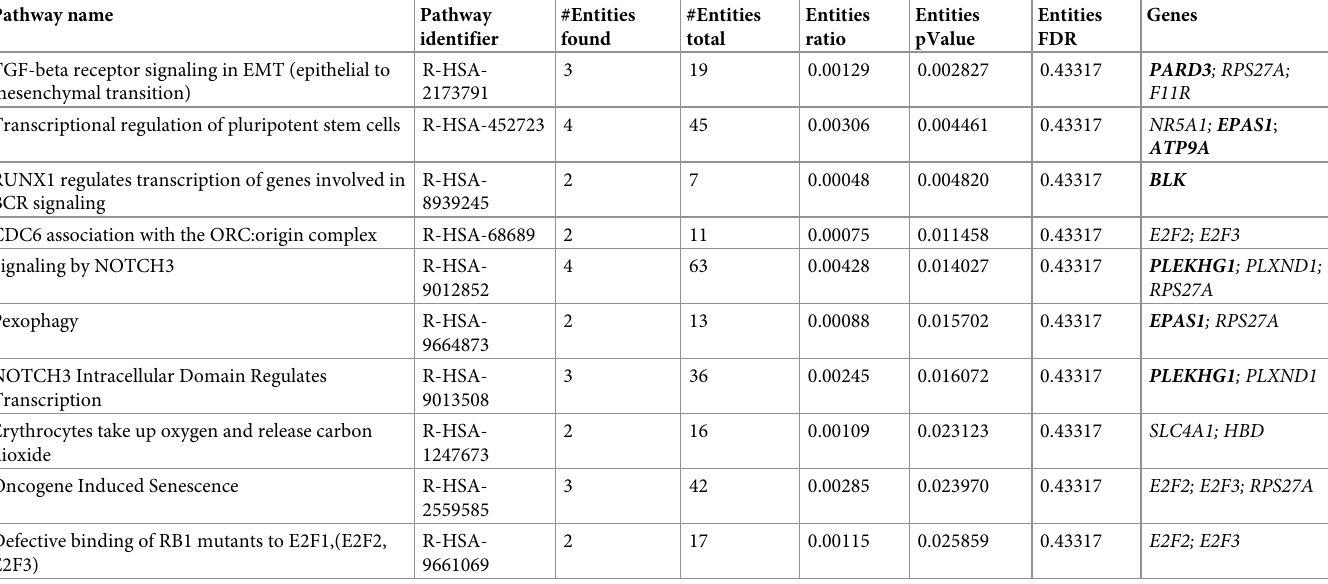
Table 2. List of the 10 most differentially expressed (both up/downregulated) gene pathways. Pathway